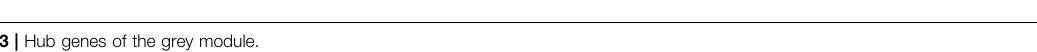
TABLE 3 | Hub genes of the grey